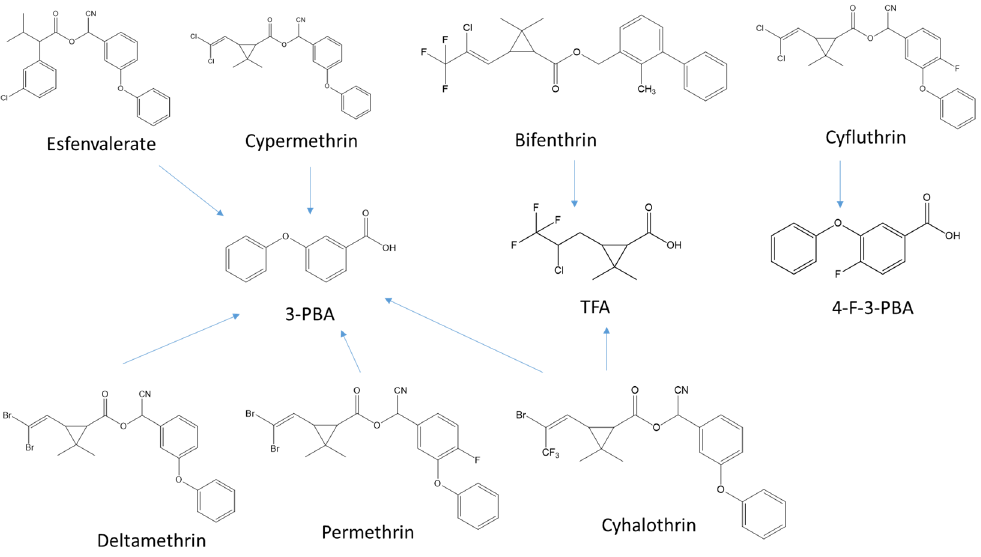
Figure 1. Transformation compounds from pyrethroids pesticides.